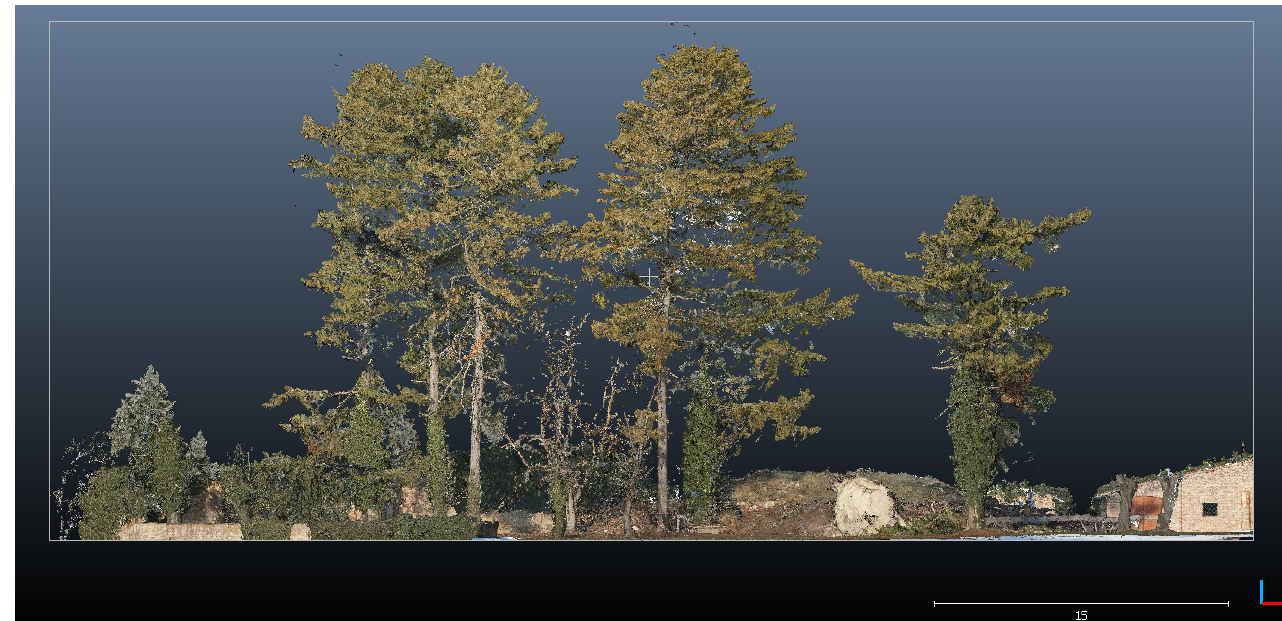
Figure 33. Vegetation of the castle captured by the P1 sensor and processed by Agisoft Metashape.